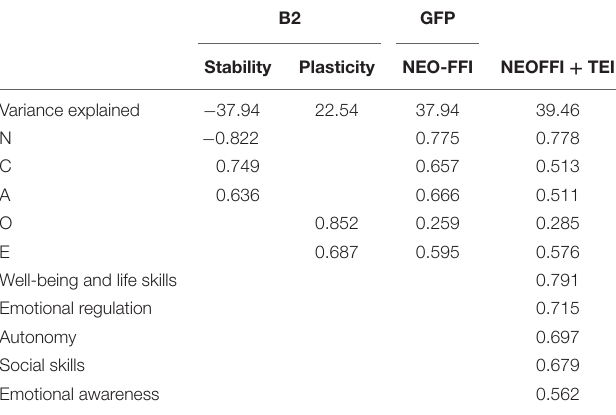
TABLE 4 | EFA results showing factor loadings for the B2 and the